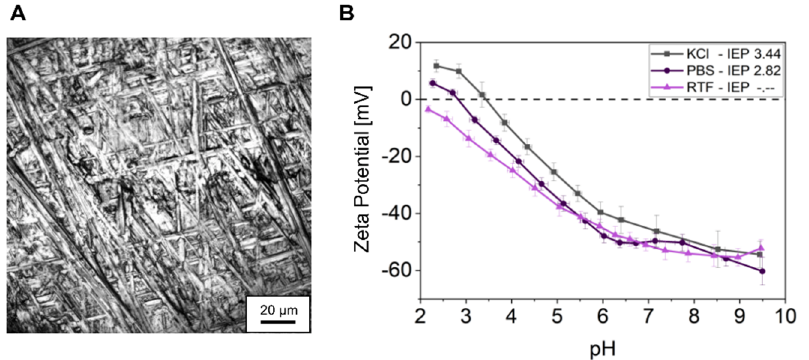
Figure 2. ( A ) Representative reflection microscopy image of the titanium surface. ( B ) Zeta potentials of titanium surfaces mean ± SD in PBS and RTF buffer as well as in KCl reference as a function of different pH; isoelectric points (IEPs) are given in the inset.